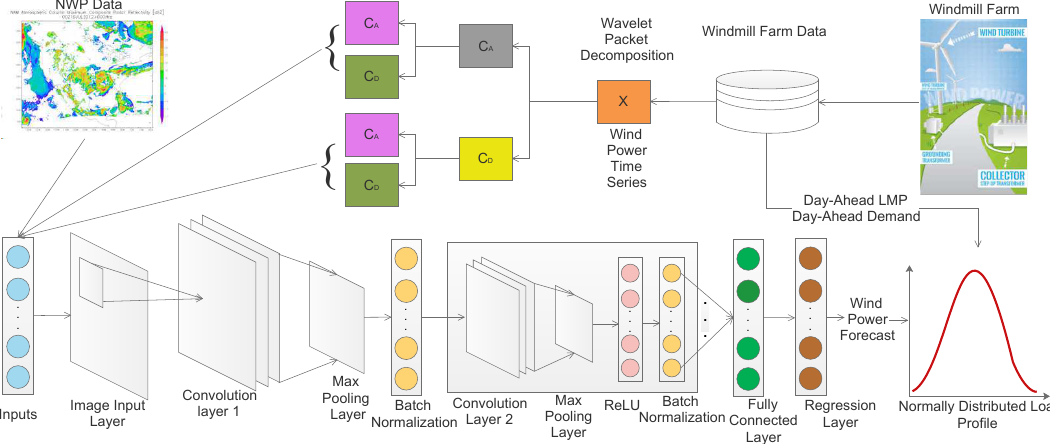
Figure 1. Overview of proposed system for wind power forecasting.